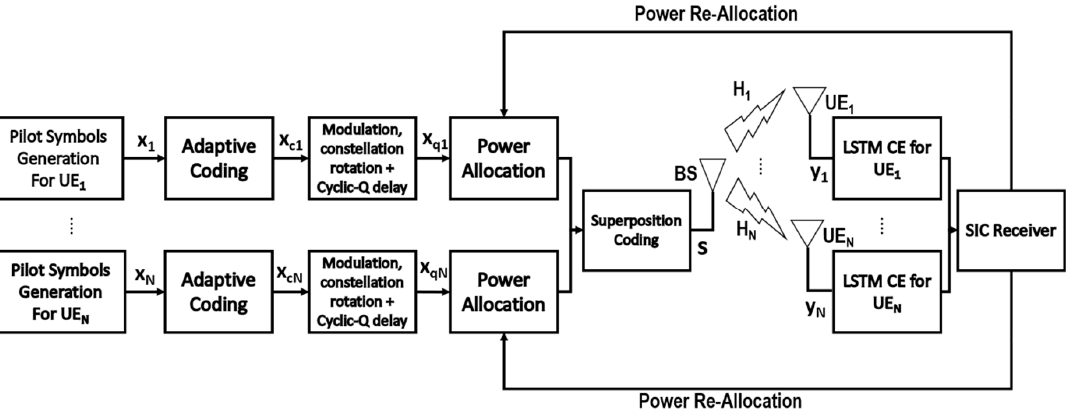
Figure 4. Block diagram of the proposed NOMA system.